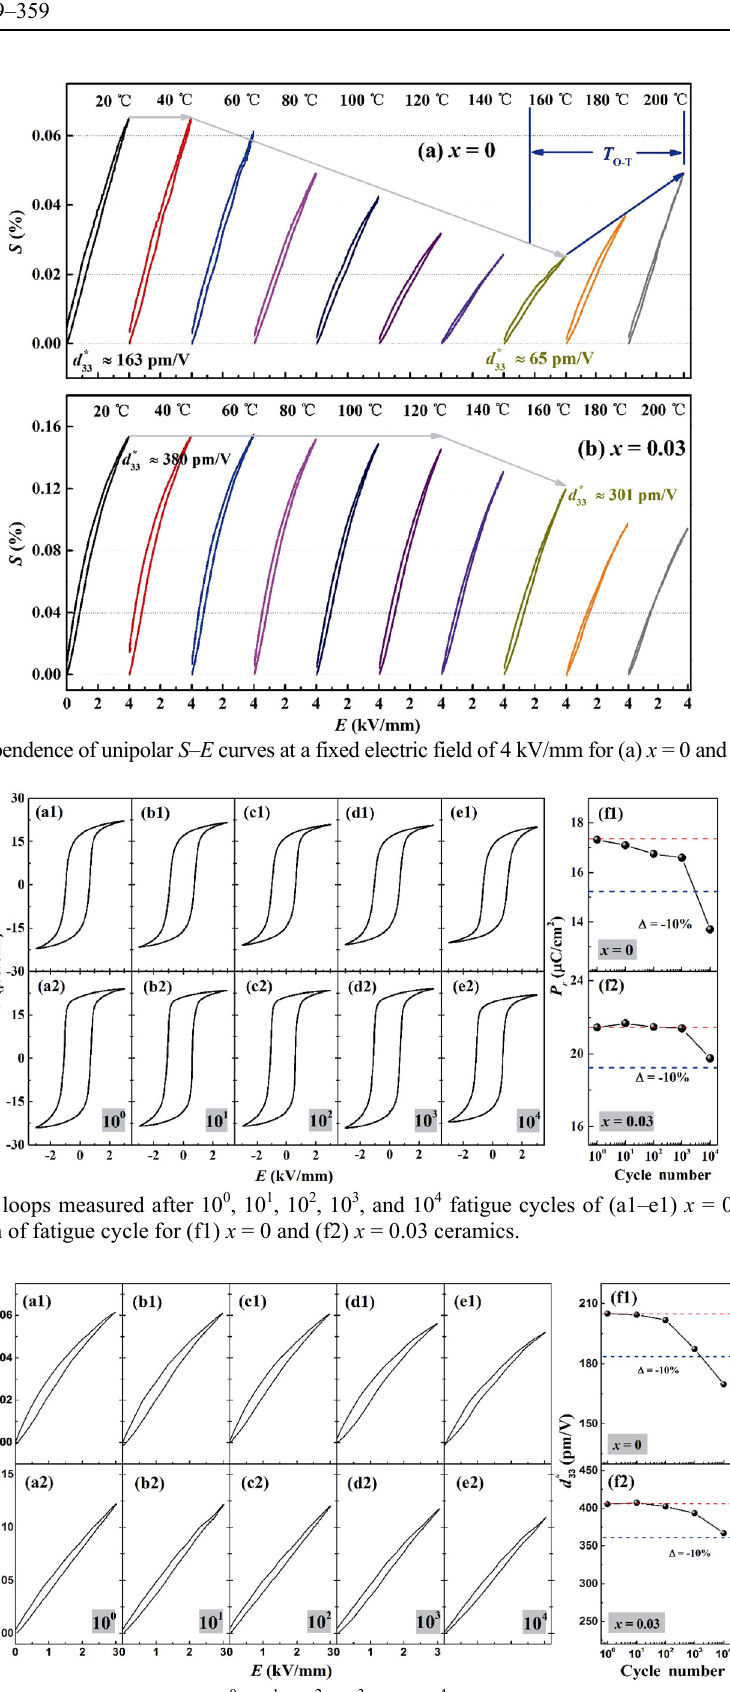
Fig. 11 Unipolar S – E curves measured after 10 0 , 10 1 , 10 2 , 10 3 , and 10 4 fatigue cycles of (a1–e1) x = 0 and (a2–e2) x = 0.03 ceramics. d 3 * 3 values as a function of fatigue cycle for (f1) x = 0 and (f2) x = 0.03